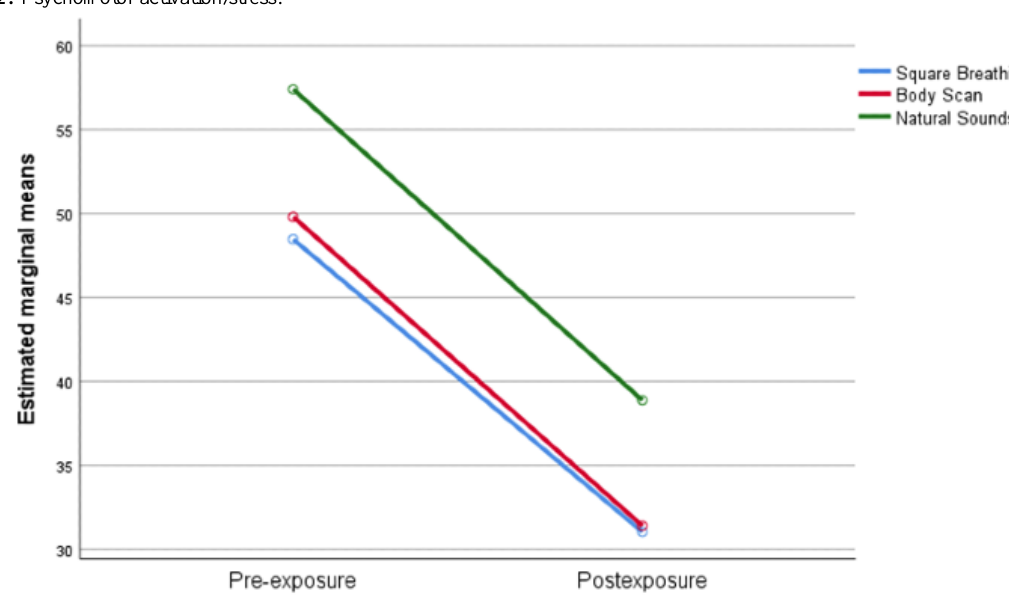
Figure 2. Psychomotor